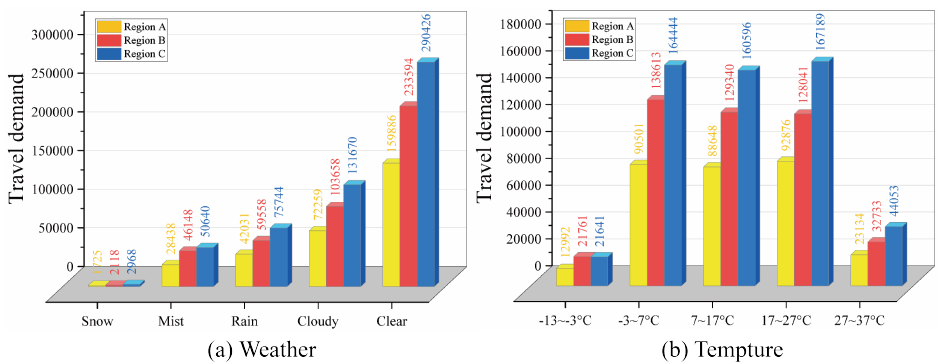
Figure 2. The influence of weather